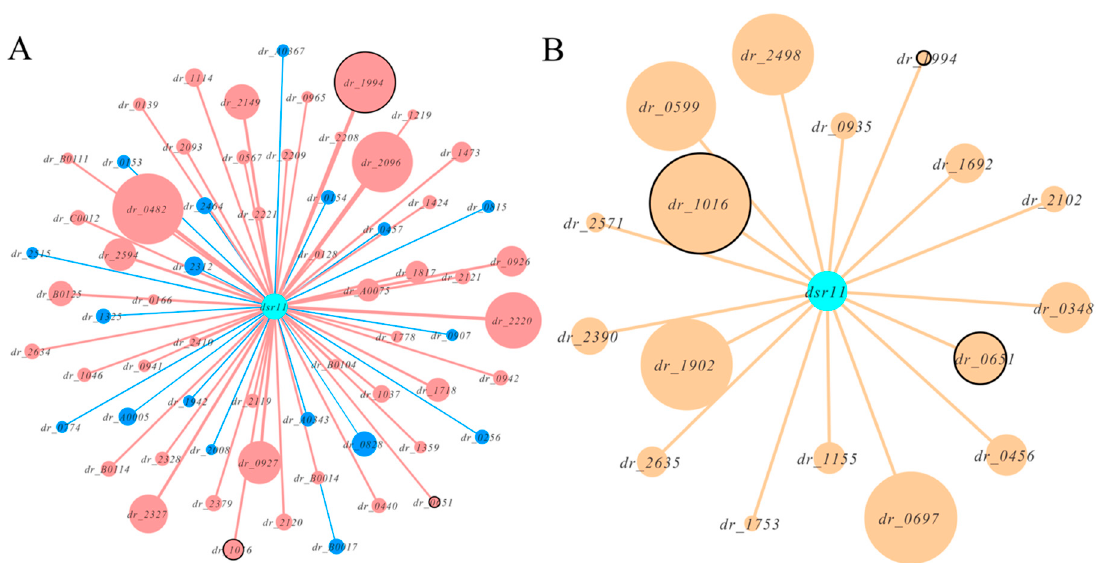
Figure 4. Network plots of dsr11 and target interactions by RNA-seq and in silico prediction. All hypothetical genes were eliminated. ( A )The effect of dsr11 knockout on gene expression by RNA-seq. Red nodes represent up-regulated genes and blue nodes represents down-regulated genes. The size of the node represents the expression. The common genes as in silico predicted are marked with black circles. ( B ) The predicted targets of dsr11 by TargetRNA2. The size of the node represents the binding strength based on the thermodynamic energy of hybridization. The common genes as RNA-seq analysis are marked with black circles.